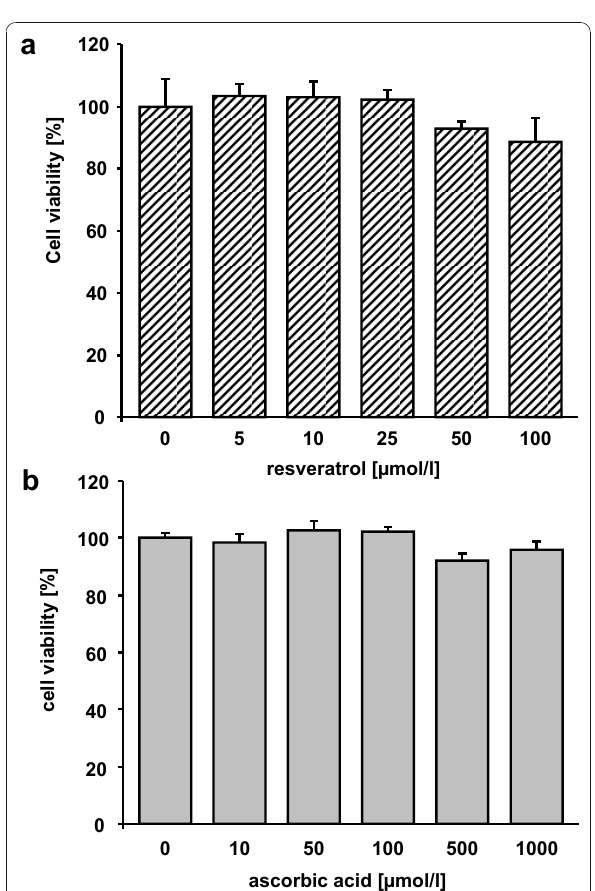
Figure 2 Cytotoxicity of resveratrol and ascorbic acid . Effects of resveratrol (a) and ascorbic acid (b) on cell viability in HUH7 cells. Data are mean ± SEM of at least 2 experiments performed in